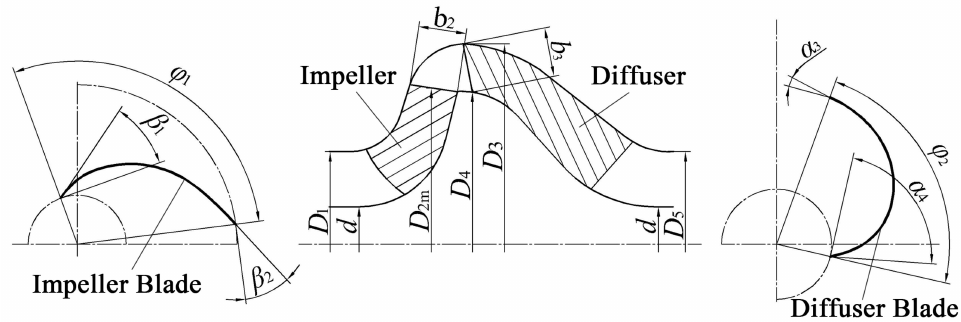
Figure 2. Meridional contour and blade profile of the impeller and